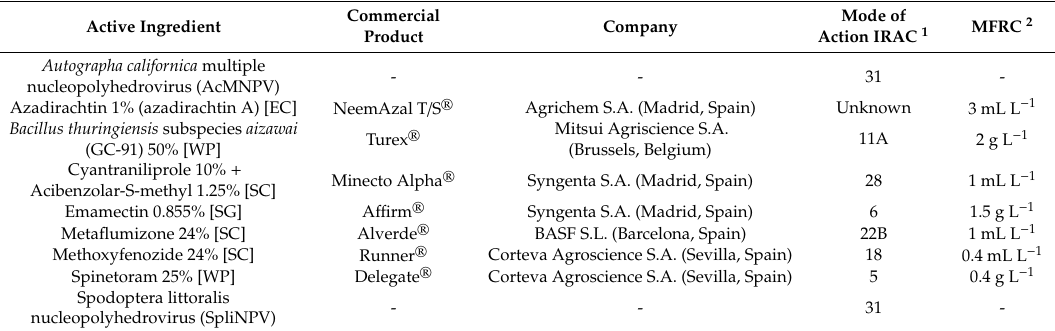
Table 1. Active ingredients, commercial products and mode of action according to IRAC classification of insecticides and nucleopolyhedroviruses tested against Spodoptera exigua and Spodoptera littoralis second instar